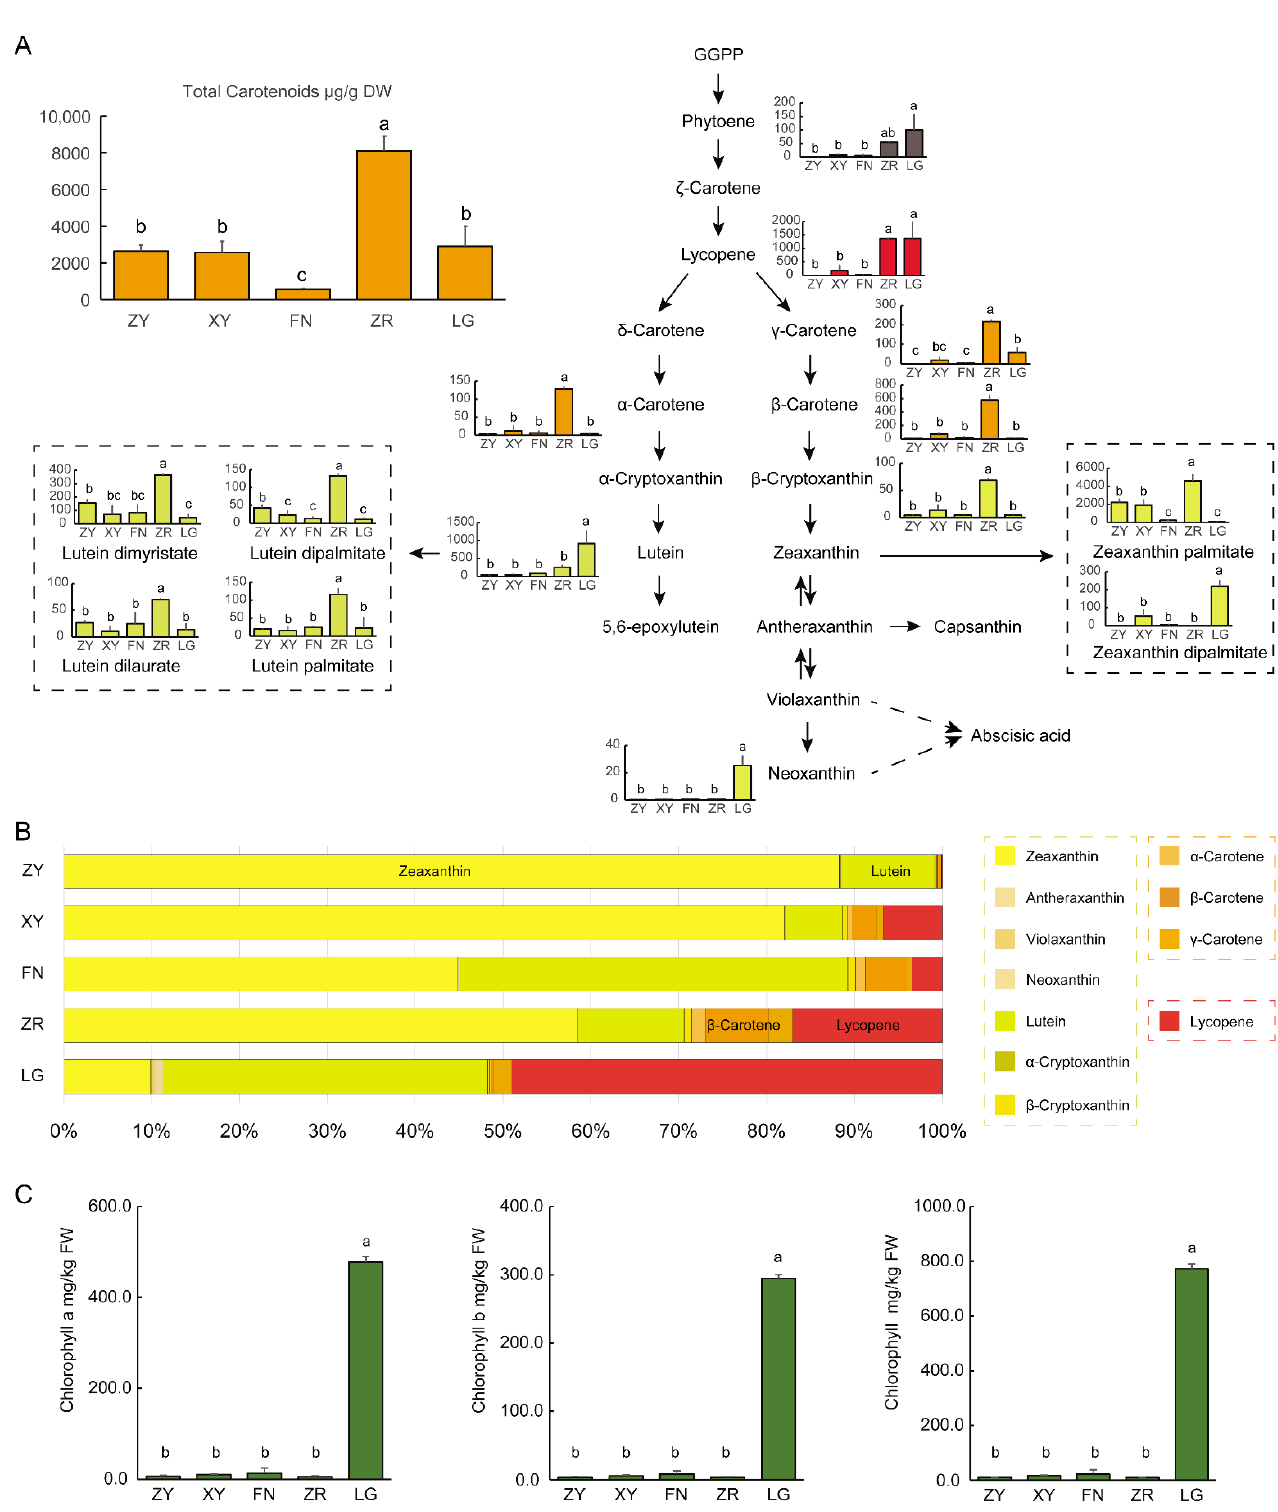
Figure 2. Quantification of carotenoids and chlorophylls in the fruits of five sea buckthorn varieties: ( A ) the carotenoid levels in the fruits of five sea buckthorn varieties; ( B ) the proportions of each colored carotenoid of the total colored carotenoids in the fruits of five sea buckthorn varieties; ( C ) the levels of chlorophylls a and b and the total chlorophylls in the fruits of five sea buckthorn varieties. Each bar represents the average of three biological replicates plus the standard deviation. Significant difference between the data were evaluated via a one-way ANOVA and labeled with different letters ( p < 0.05).